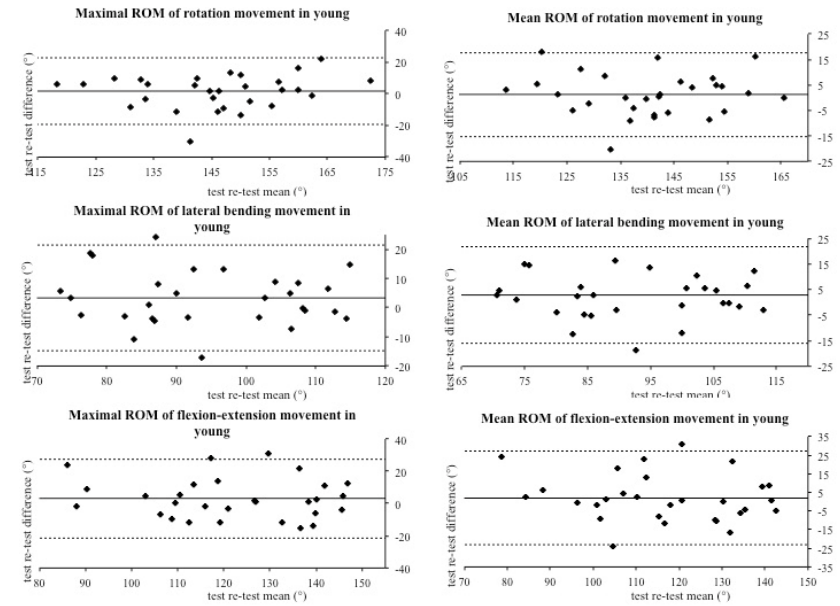
Figure 2. Bland–Altman plots of maximum and mean range of motion in young subjects. J. Funct. Morphol. Kinesiol. 2020 , 5 , x FOR PEER REVIEW